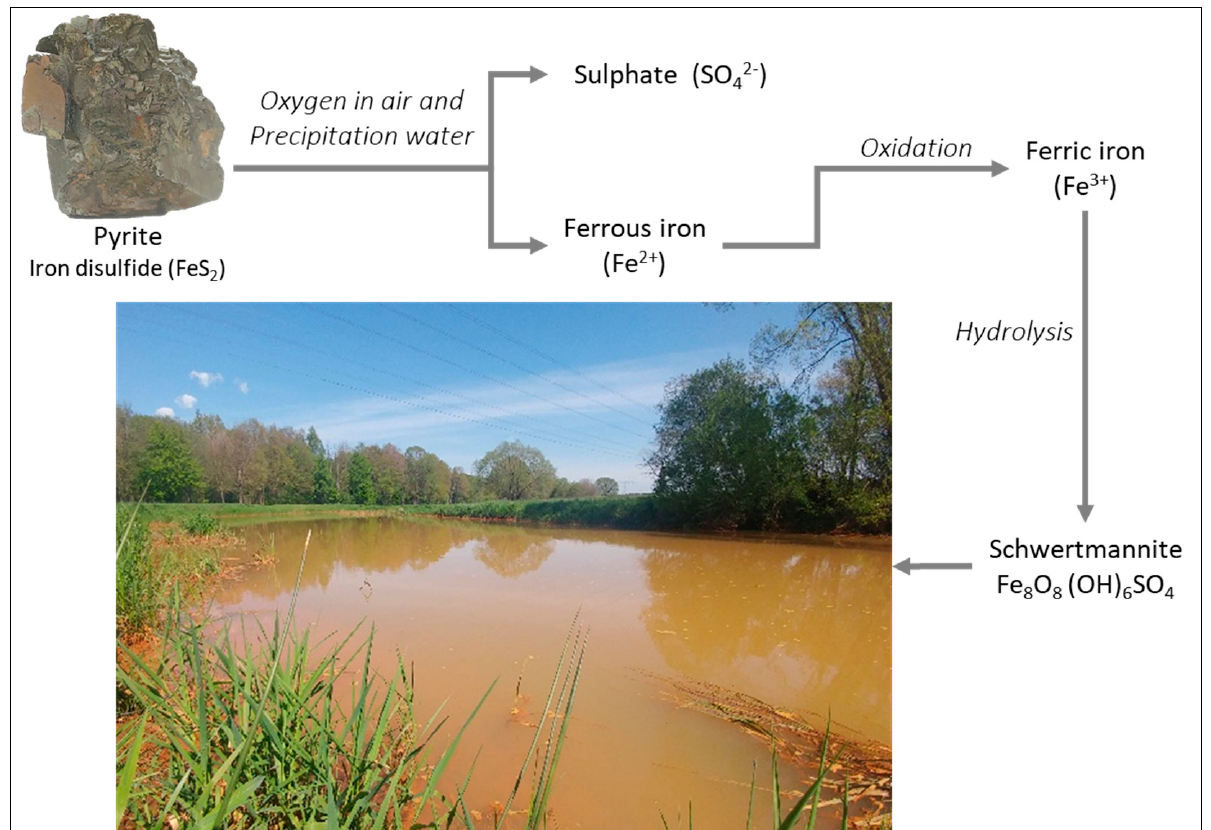
Figure 2. Schematic diagram of the weathering of pyrite from the source material (pyrite) to the clogging in the flowing water (Spree), Fe(III)-oxyhydroxide is represented by Schwertmannite. The municipalities of Ruhlmühle and Spreewitz, the mouth of the industrial canal of Schwarze Pumpe industrial park, the pre-dam Bühlow and the Spremberg reservoir were significant spots in the study area (Figure 1). Analyses conducted by Bilek and Koch [6] showed the discharge of Fe(II) loads from anoxic groundwater into the oxygen-rich river water. Uhlmann et al. [52] observed the input of large amounts of Fe(II) into the river at the village Ruhlmühle (SP 1 in (Figure 1). In the oxygen-rich water and under natural pH conditions, the Fe(II)-oxide flocculated out as Fe(III)-oxyhydroxide, causing an ochre colour in the river